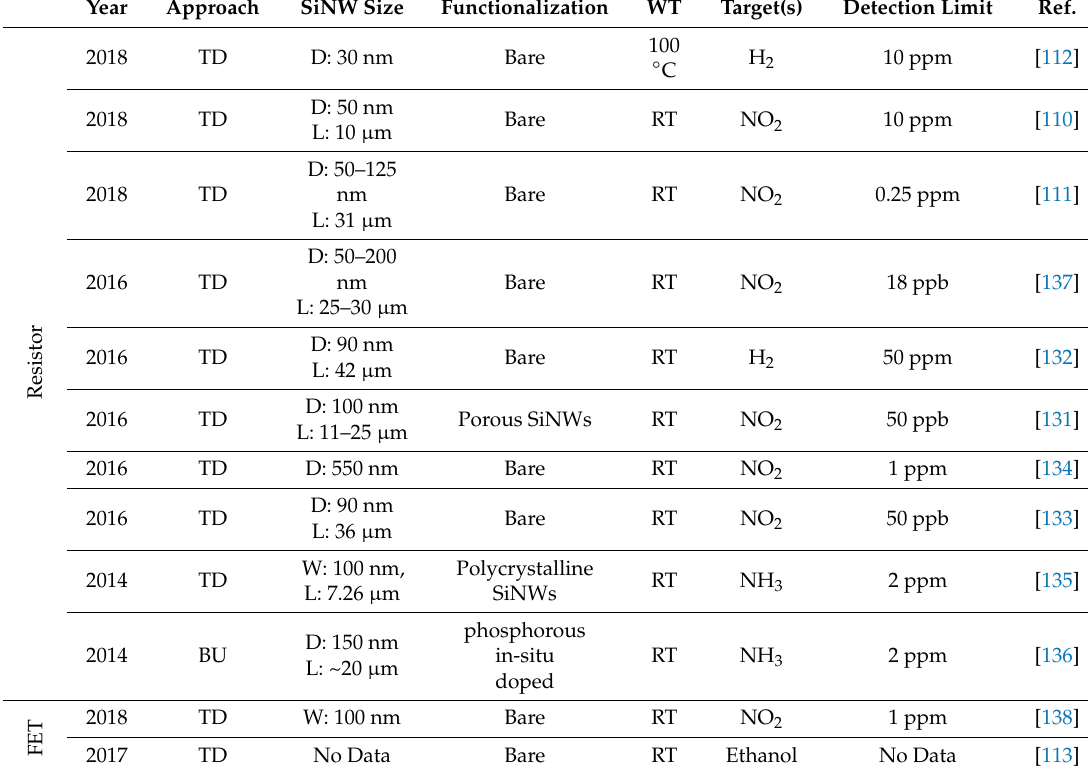
Table 3. Overview of bare SiNW gas sensors for detecting various